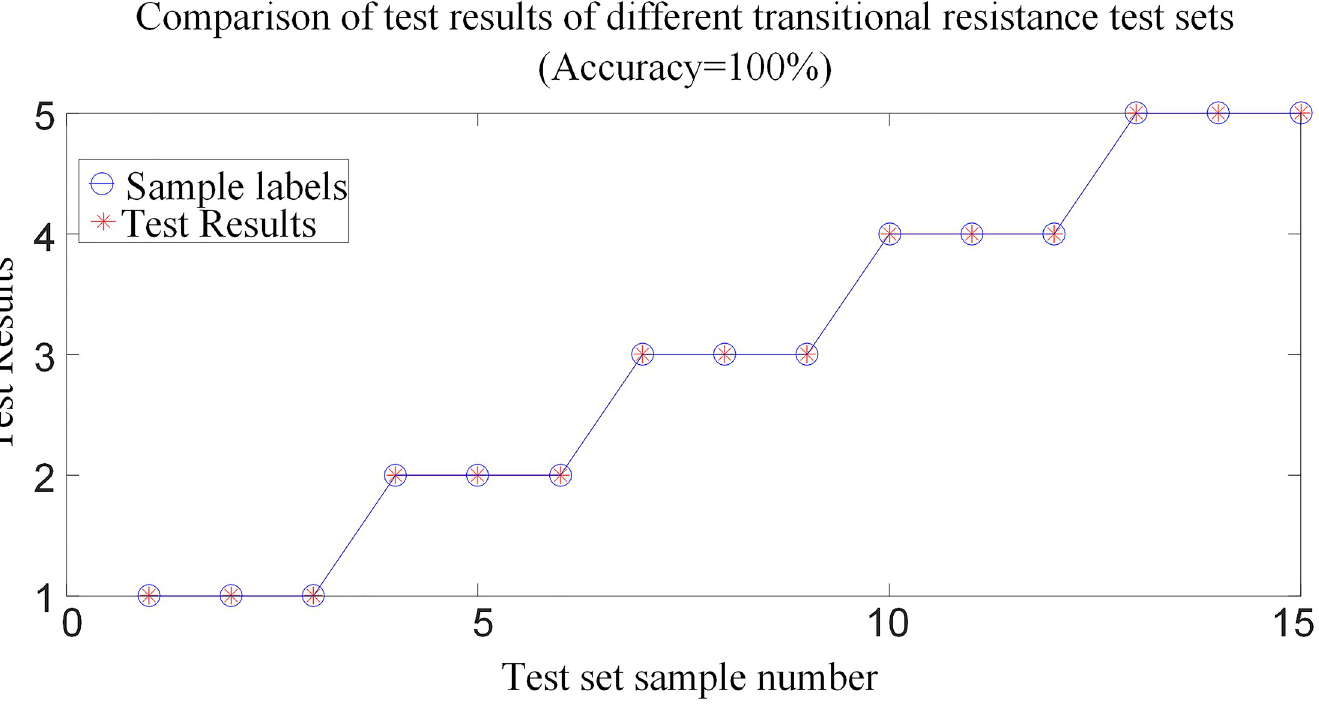
Fig 15. Comparison of test results when faults with different transitional resistances occur.